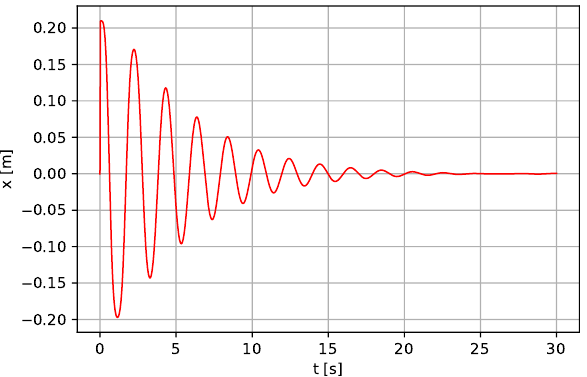
Figure 16. Linear displacement x ( t ) of the lever (continued) for l = 1.2 m, b = 0.3 N